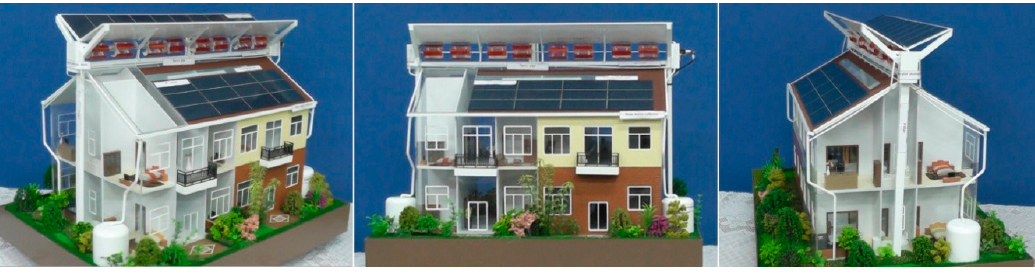
Figure 2. The model of the system.